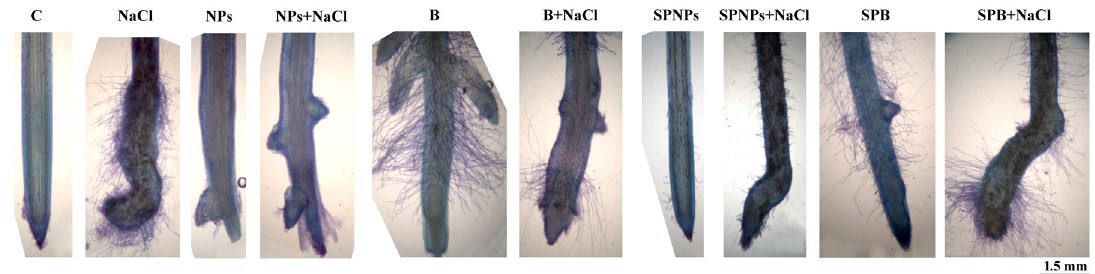
Figure 3. Roots of T. turgidum L. ssp. durum cv. Cappelli stained with toluidine blue and observed using an optical microscope to evaluate their general morphology and architecture: roots without priming and salt treatment (C), with salt treatment without priming (NaCl), with ZnO treatment in the root zone (nanoparticles, NPs or bulk form, B), with ZnO priming in the root zone with salt treatment (NPs + NaCl or B + NaCl), with ZnO treatment as a leaf spray (SPNPs or SPB), and with ZnO priming as a leaf spray with salt treatment (SPNPs + NaCl or SPB + NaCl).